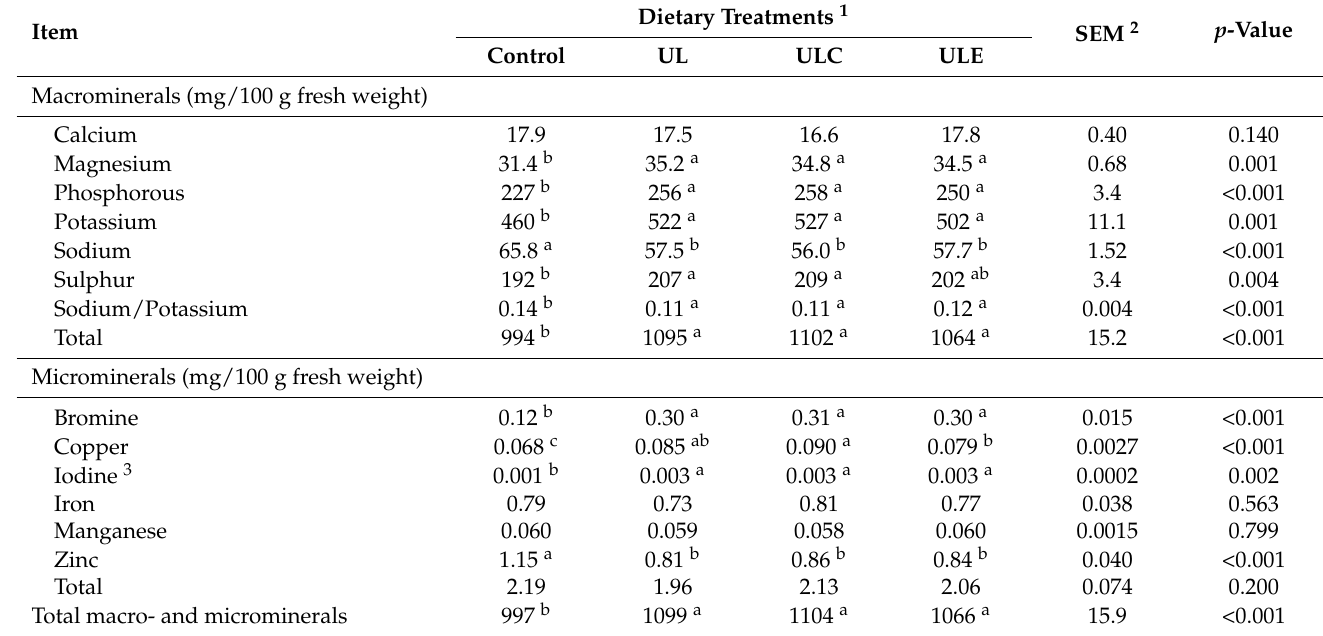
Table 7. Mineral composition of breast and thigh meats of broilers ( n =